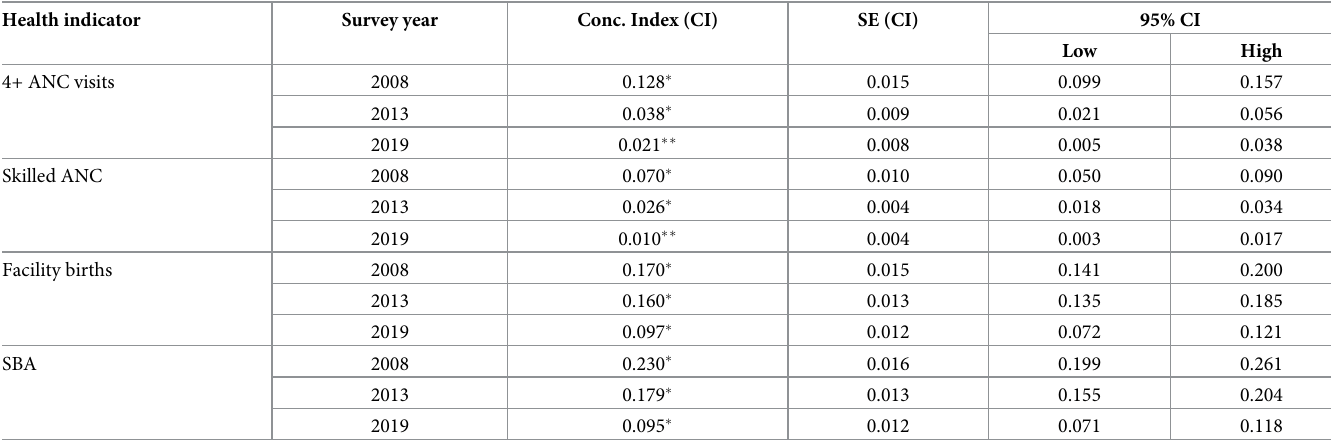
Table 6. Concentration indices showing education-based inequality in the use of maternal health services in Sierra Leone, 2008, 2013 and 2019. Health